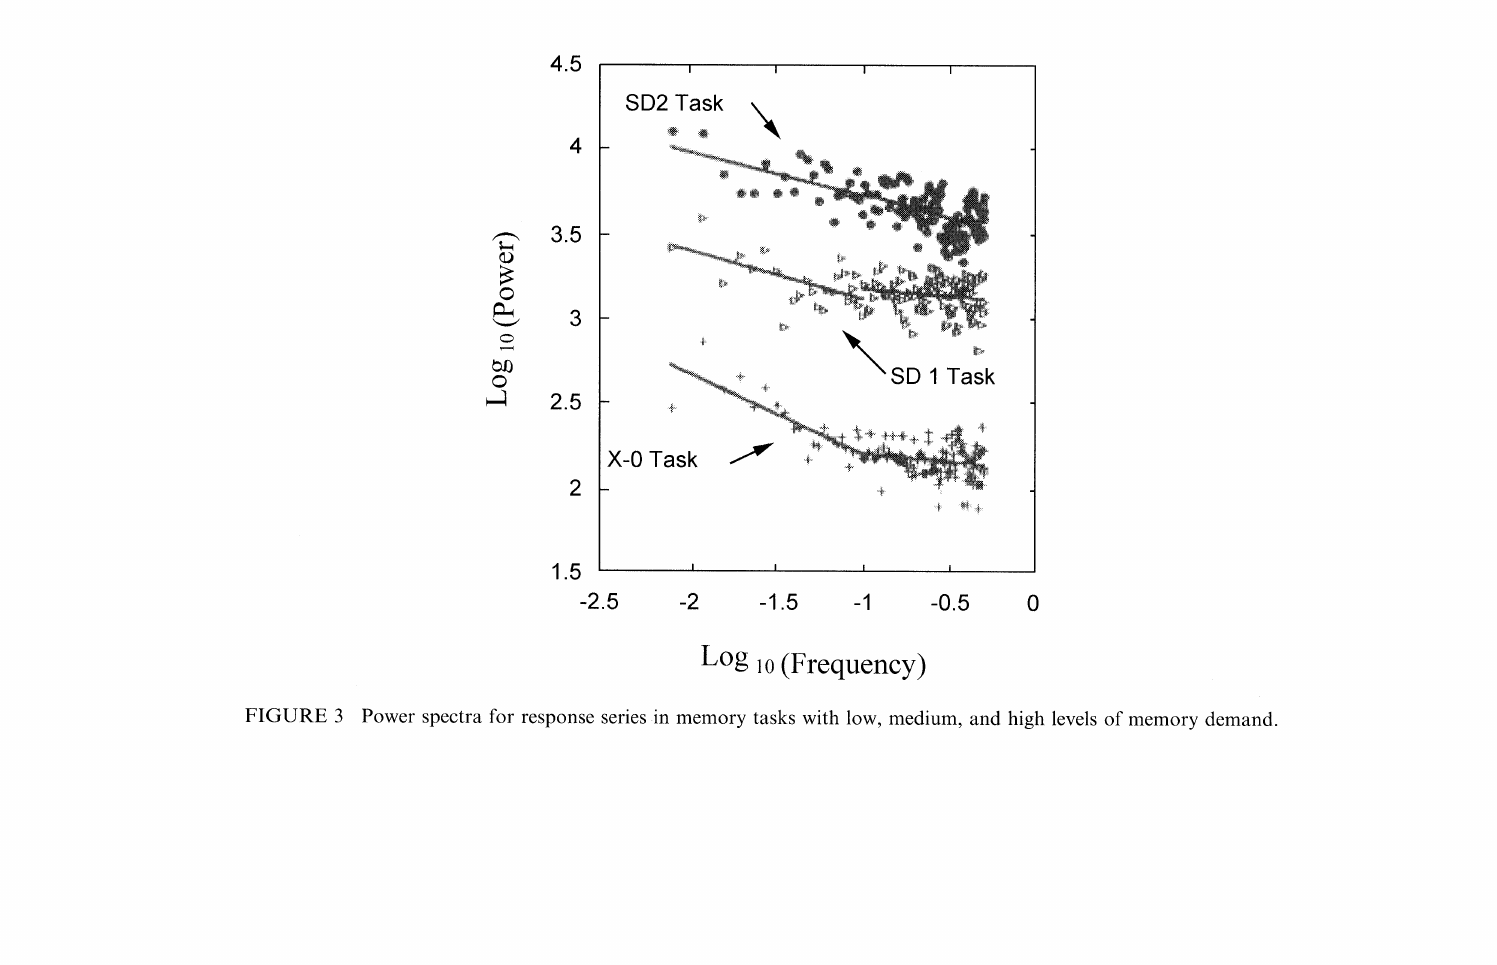
FIGURE 3 Power spectra for response series in memory tasks with low, medium, and high levels of memory